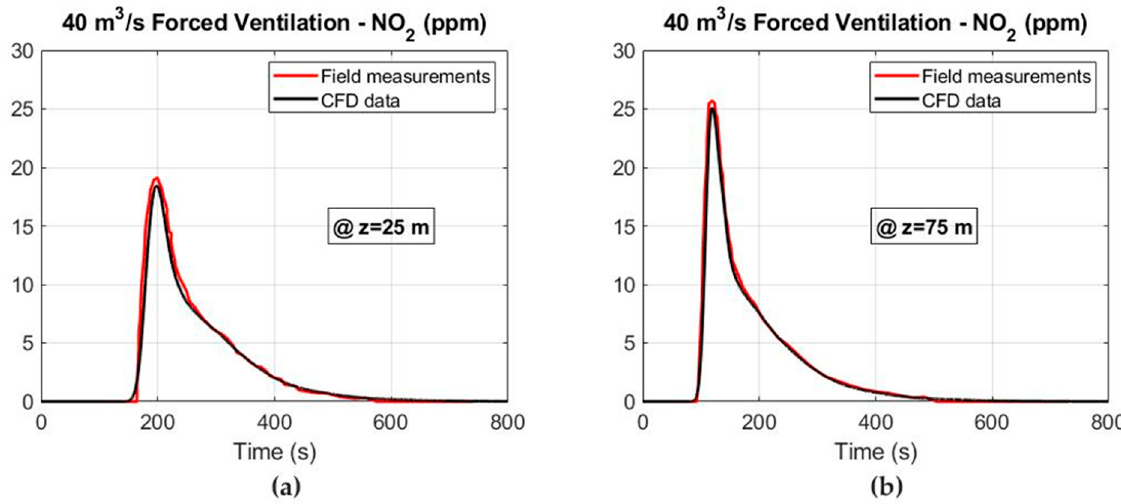
Figure 11. CFD results and field measurements considering an airflow of 40 m 3 s − 1 under the forced ventilation mode: ( a ) NO 2 concentration at Z = 25 m and ( b ) NO 2 concentration at Z = 75 m.